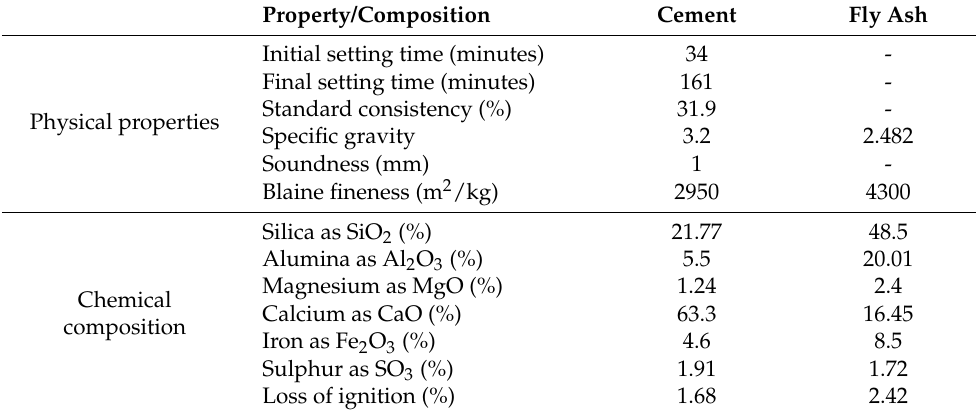
Table 1. Physical properties and chemical composition of the cement and fly ash. Property/Composition Cement Fly